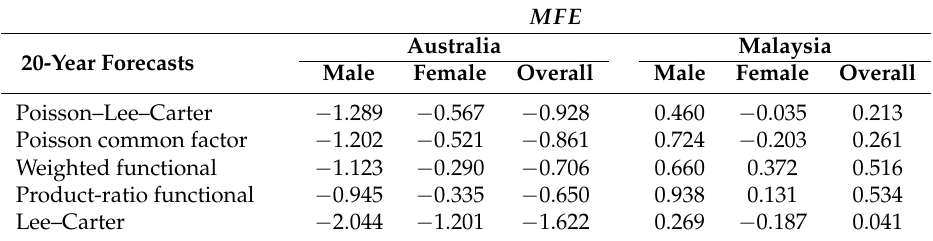
Table 5. Mean Forecast Error ( MFE ) of life expectancy at birth by method, gender and